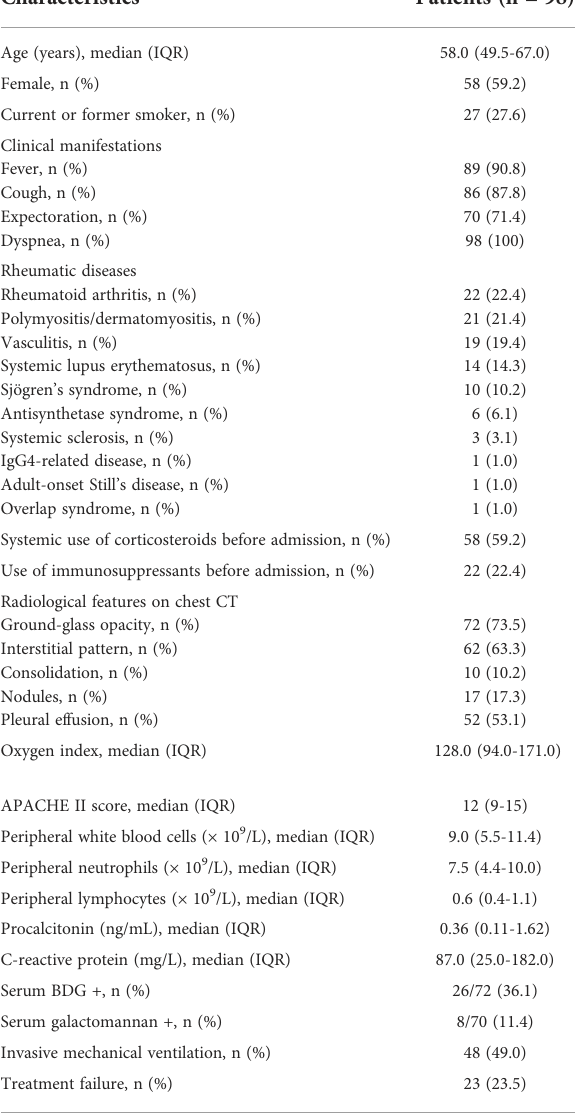
TABLE 1 Clinical characteristics of enrolled patients.